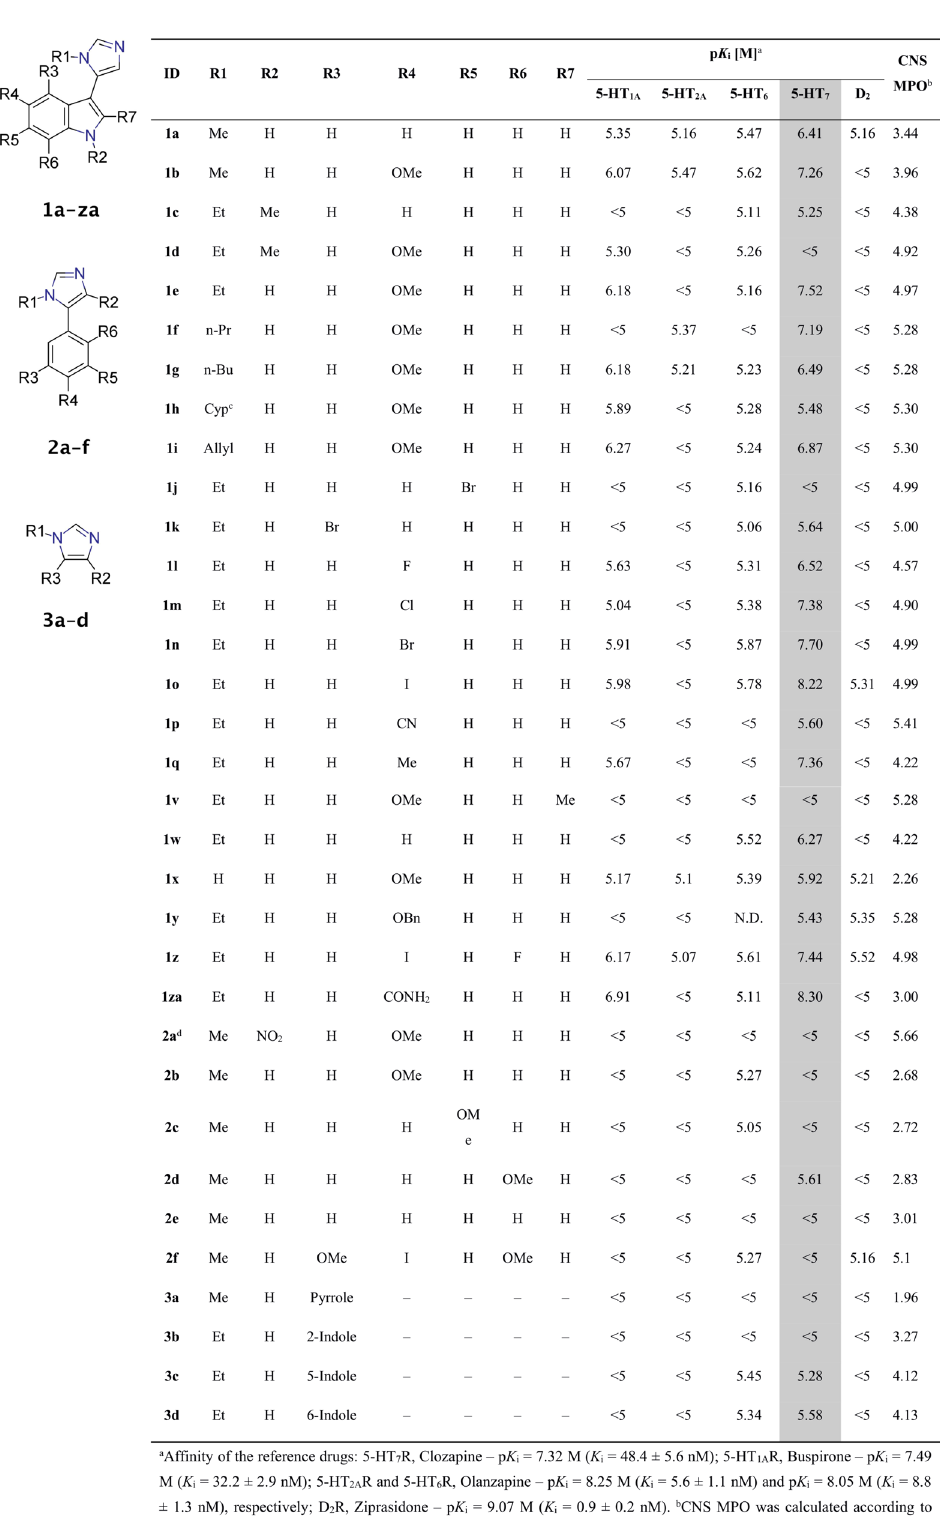
Figure 2. Structure, binding data and Central Nervous System Multiparameter Optimization score (CNS MPO) of compounds 1a – 1za , 2a – 2f and 3a – 3d